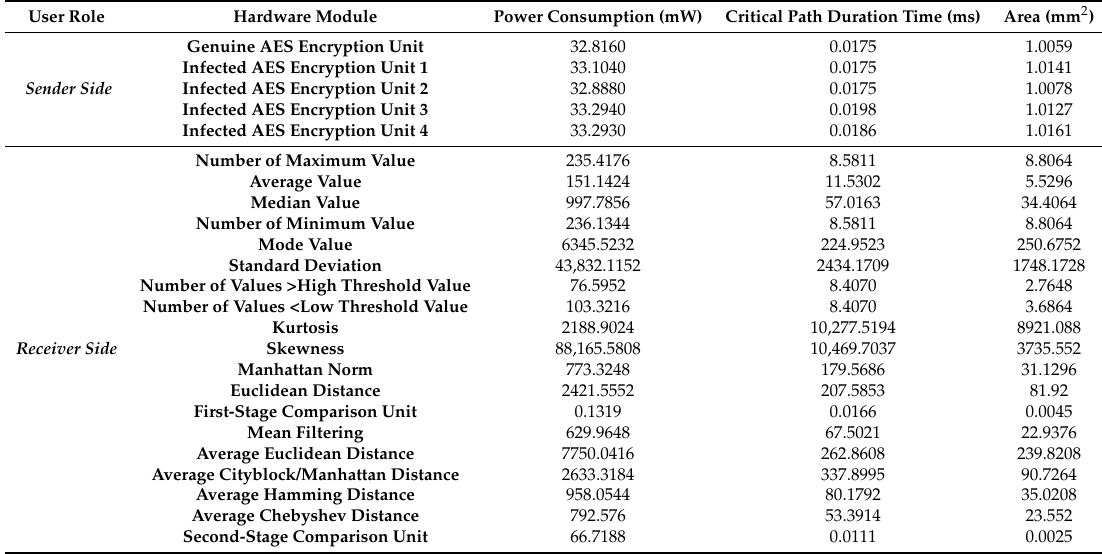
Table 5. Hardware evaluation results: The synthesis results of the hardware elements of the healthy and the infected cross-layer biometric recognition